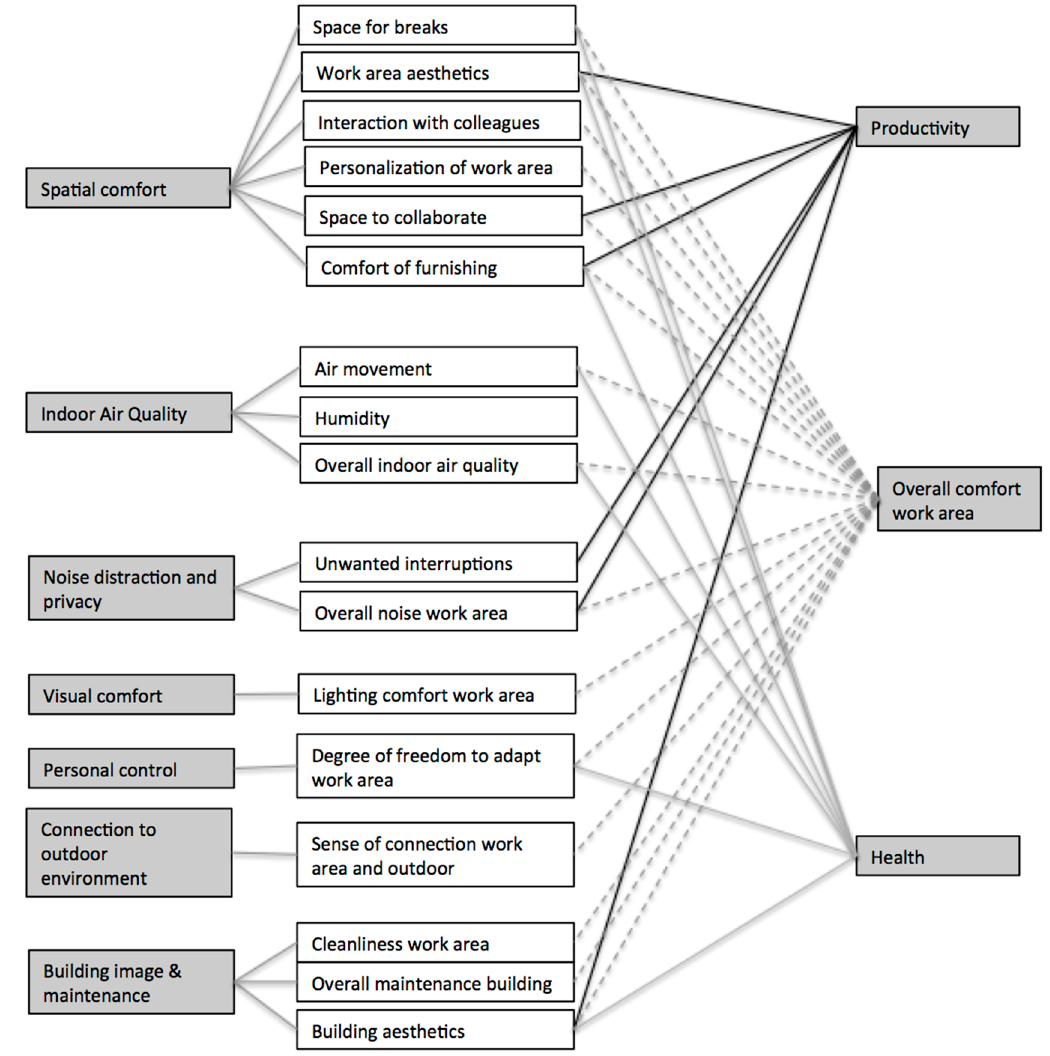
Figure 1. Large-size correlation associations for perceived productivity, health, and overall comfort work area found in the entire